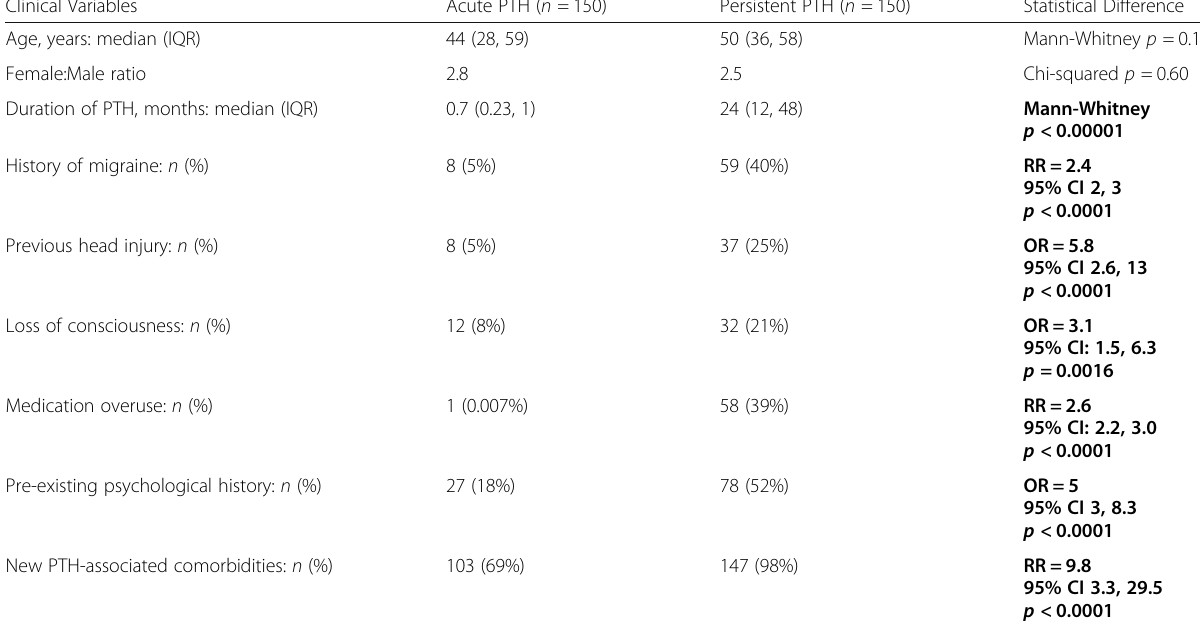
Table 1 Clinical features of acute and persistent PTH patients included in the study Clinical